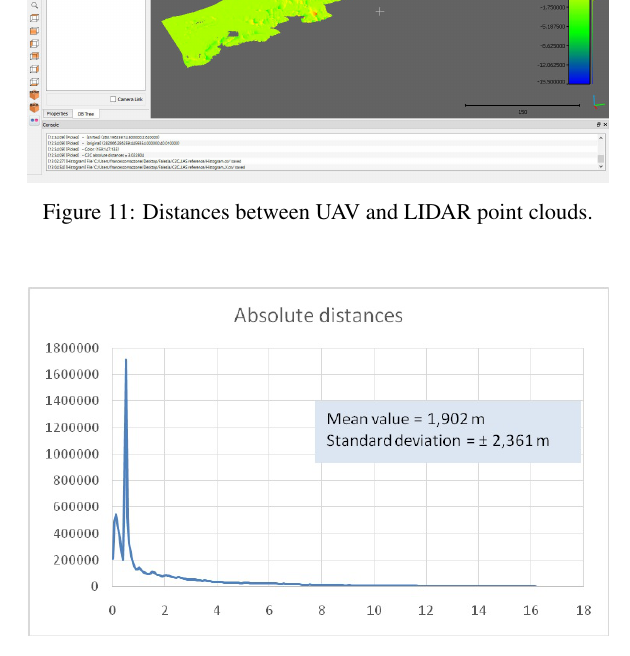
Figure 12: Absolute